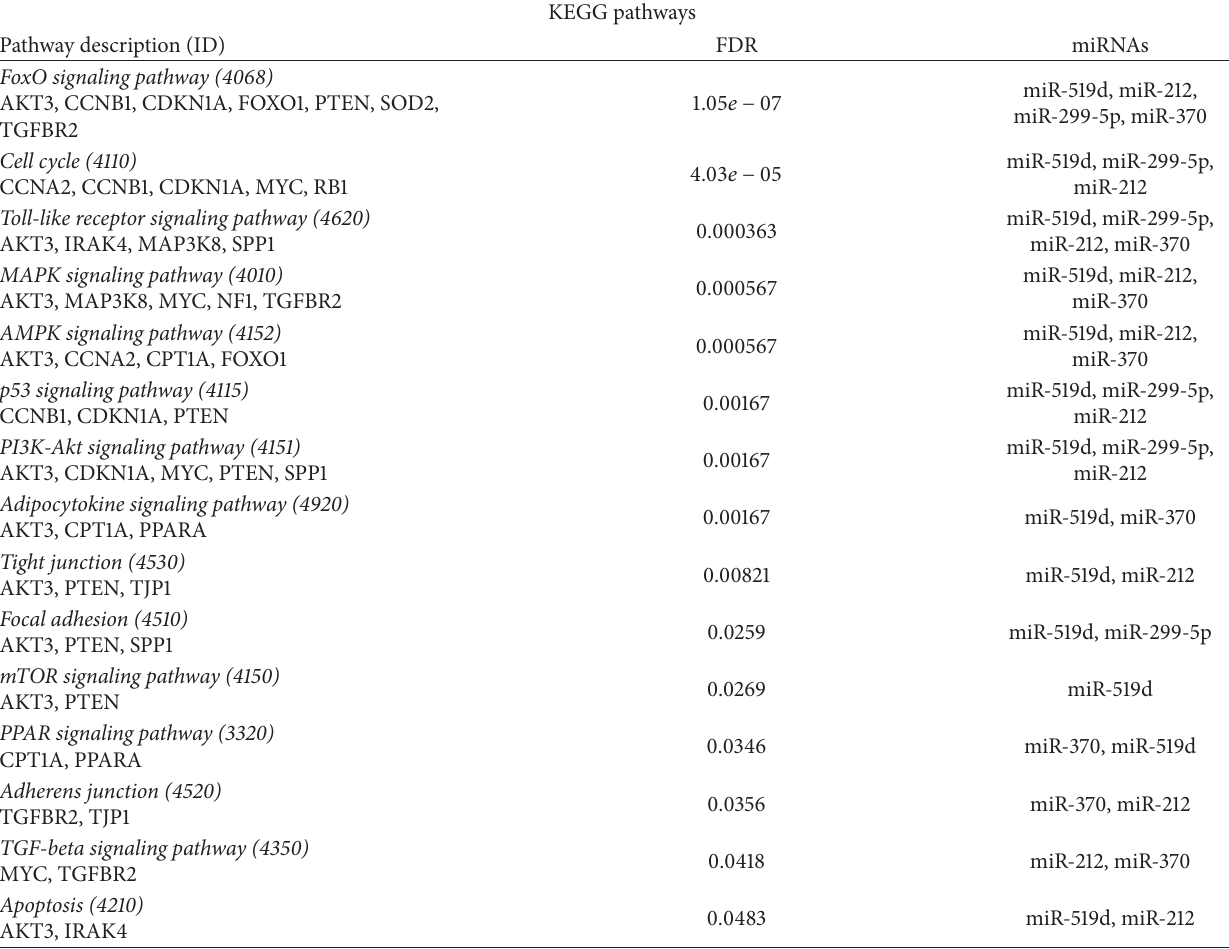
Table 3: Metabolic pathways predicted to change by our miRNAs after LAGB. The most significant pathways ( 𝑝 < 0.005 ) predicted by KEGG to contain genes targeted by the 6 miRNAs whose expression changed three years after LAGB.